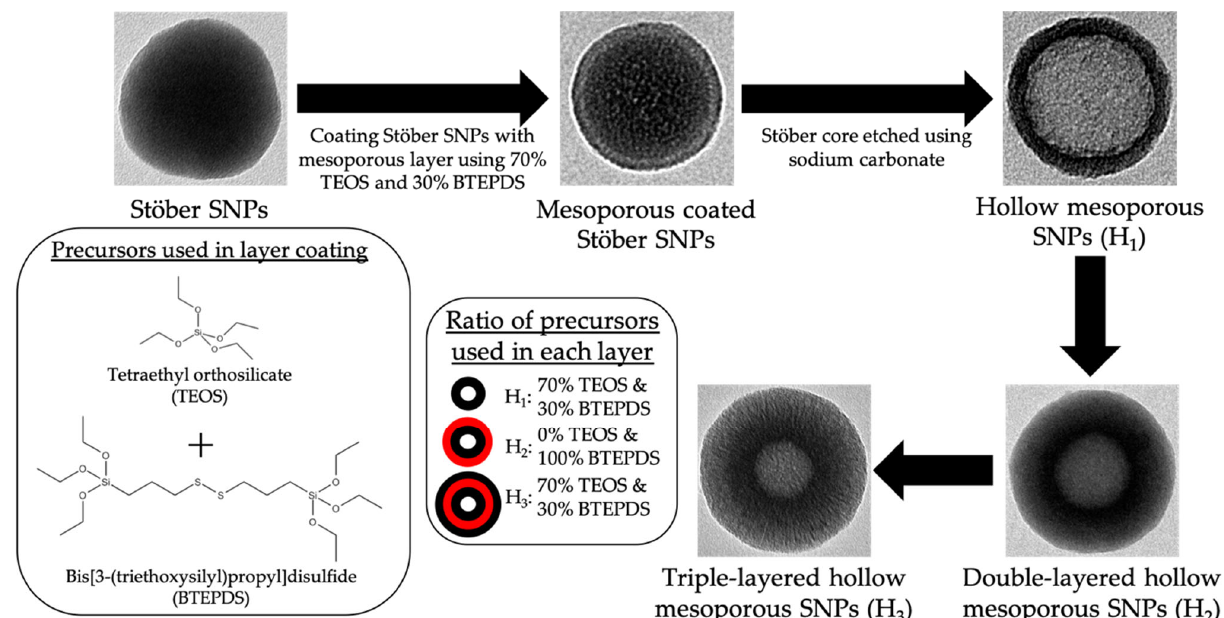
Scheme 1. Top panel: the process of fabricating HMSNPs (H 1 ) starting from a dense Stöber core. Bottom panel from left to right: the structure of the alkoxysilane precursors TEOS and BTEPDS, precursor ratios for outer shell layer of each nanoparticle with black circles representing 70% TEOS & 30% BTEPDS and red circles representing 100% BTEPDS, differentiating HMSNPs into layer ‐ by ‐ layer HMSNPs: H 2 as double ‐ layered particles; and H 3 as triple ‐ layered particles.